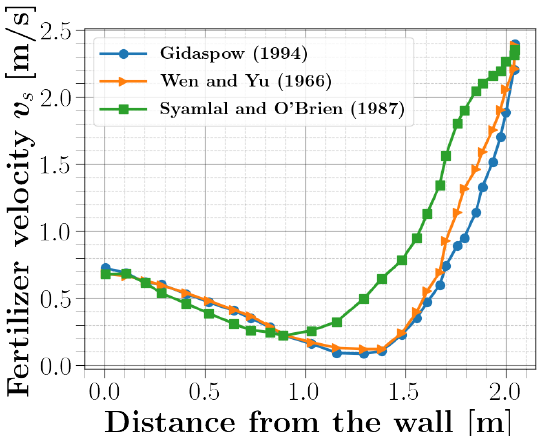
Figure 6. The fertilizer particle velocity distributions predicted using the three drag models for a rotational speed of 8 rpm and a 30% filling